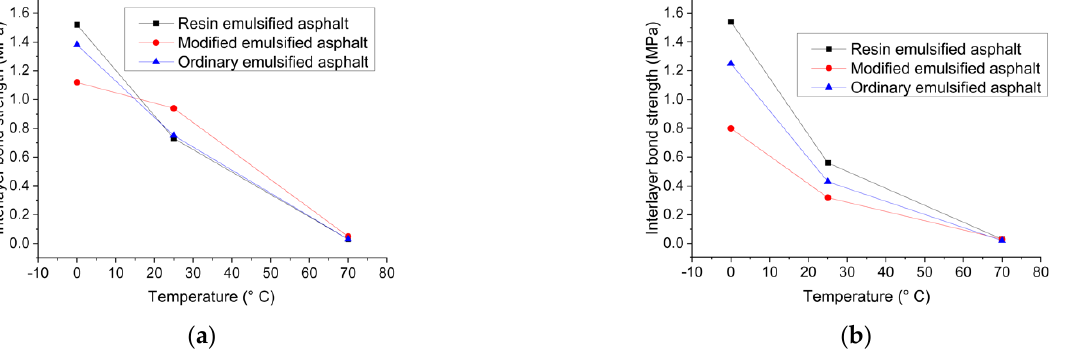
Figure 14. Interlayer shear strength of three adhesive materials in two structures: ( a ) Structure I; ( b ) Structure II. ( b ) Structure